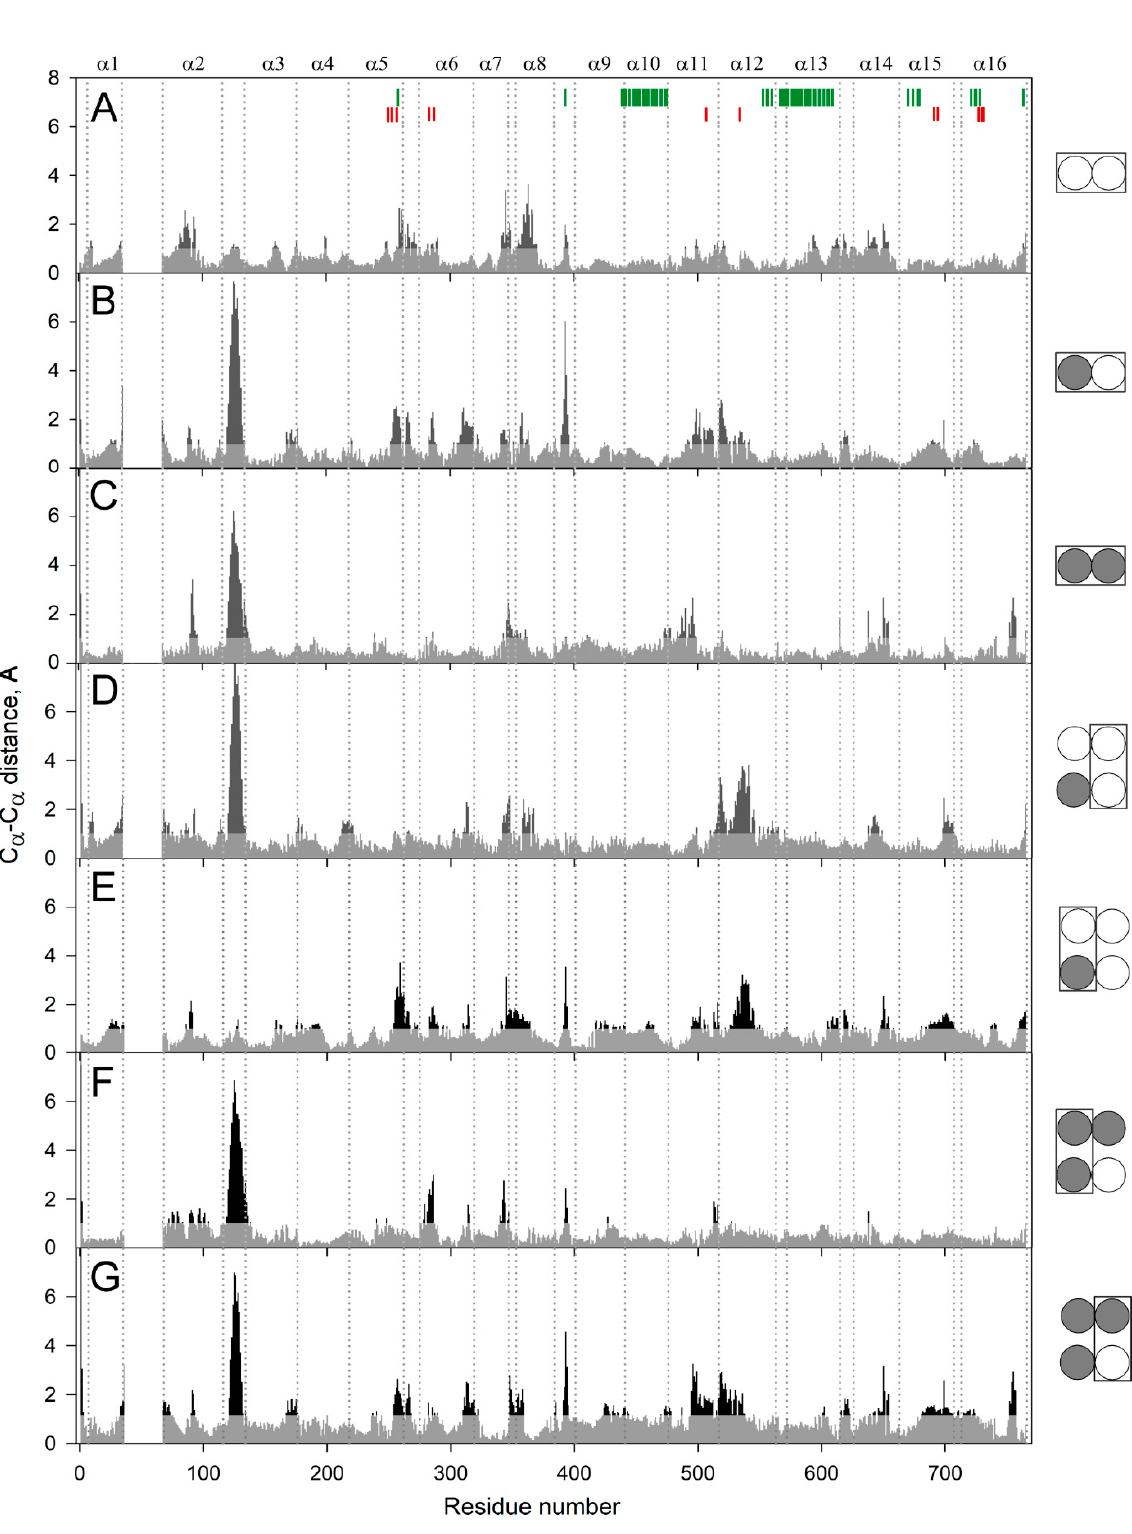
Figure 2. C α atom displacements between superimposed MD-simulated subunit structures of the different IDP complexes of Vr-mPPase. The schemes on the right indicate the binding state of the subunits compared within or between dimer(s) in panels ( A – G ). IDP-free and IDP-bound subunits are shown as open and closed circles, respectively; the superimposed subunits are boxed. Black areas on the profile refer to the residues whose C α atoms misalign by > 1 Å in the structures compared. Vertical dotted lines separate the residues belonging to different α -helices, as indicated above in panel ( A ). The vertical bars on the top panel mark residues belonging to the active site (red) and the subunit contact zone